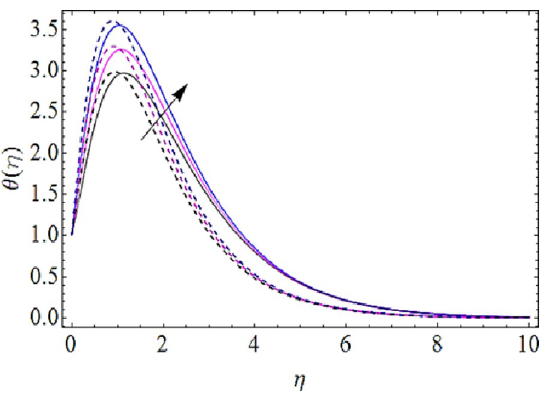
Fig 6. Thermal characteristics for different values of magnetic